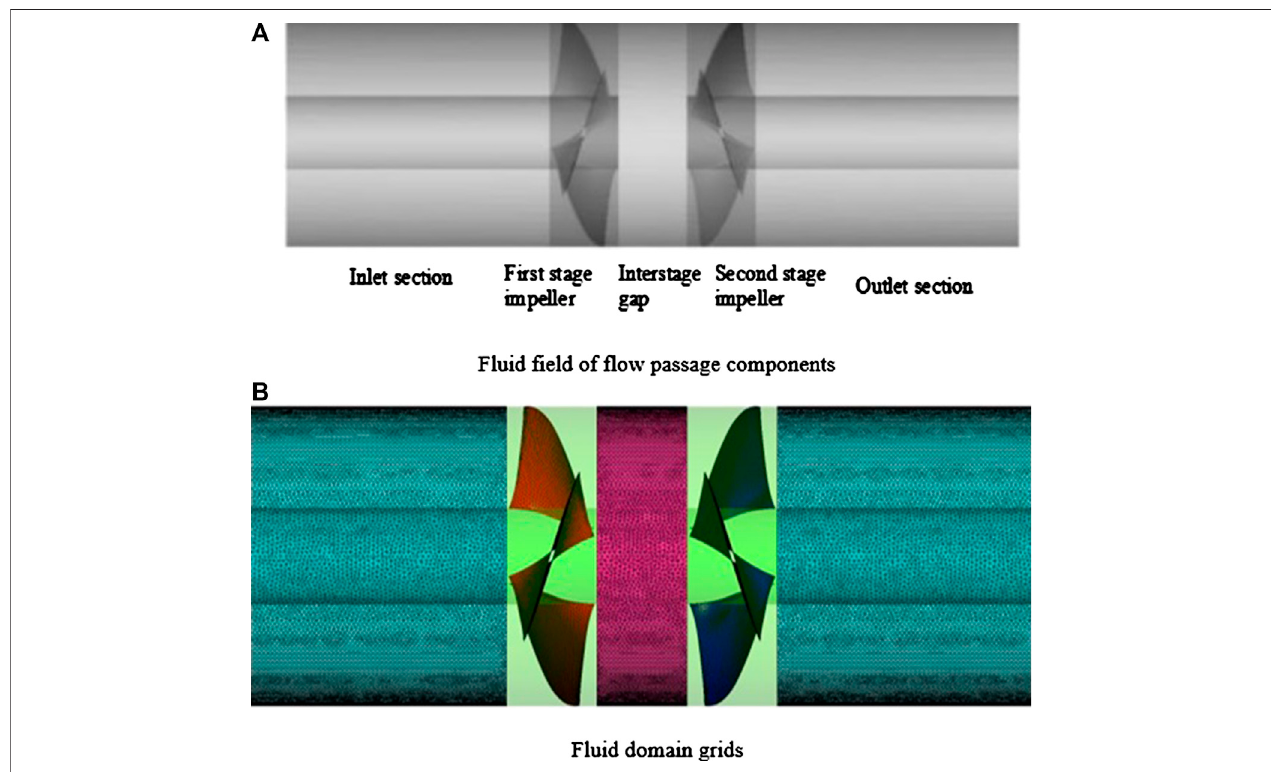
FIGURE 8 | Flow fi eld and meshing of fl ow passage components. (A) Fluid fi eld of fl ow passage components. (B) Fluid domain grids.